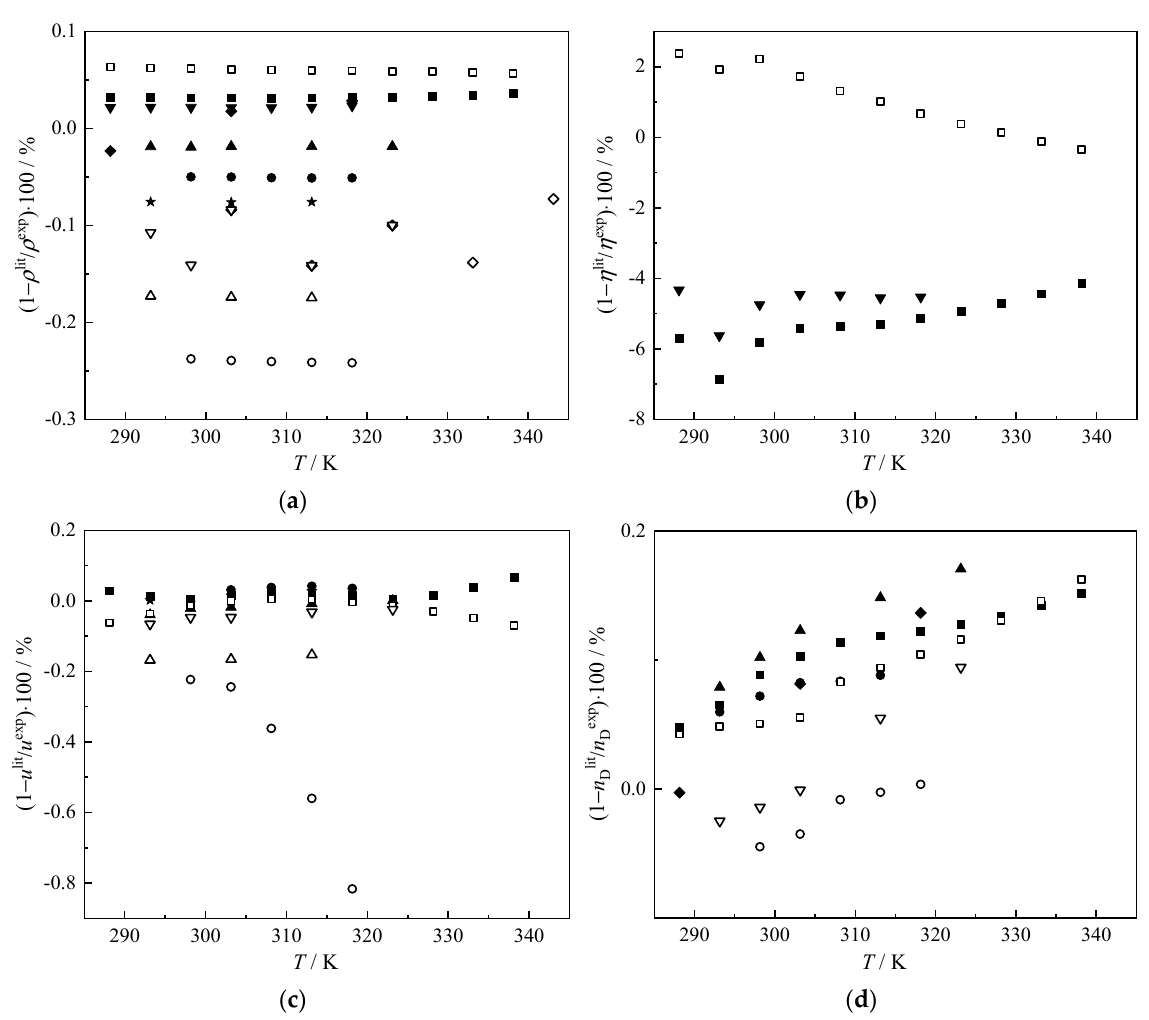
Figure 1. The percentage deviations of the measured ( a ) density, ρ , ( b ) dynamic viscosity, η , ( c ) speed of sound, u , and ( d ) refractive index, n D , from the literature data reported by: ( ) Almeida et al. [15], ( ) Bendiaf et al. [13], ( , ) Lomba et al. [12], ( ) Belhadj et al. [20], ( , ) Nduli and Deenadayalu [18], ( ) Qureshi et al. [17], ( ) Hough et al. [16], ( ) Zaoui- Djelloul-Daouadji et al. [14], and ( ) Mahi et al. [19] for furfural (full symbols) and furfuryl alcohol (empty symbols).